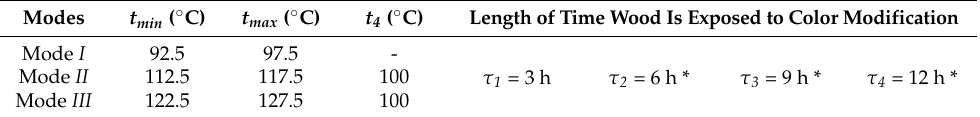
Table 1. Modes of color modification of alder wood with saturated steam-air mixture and saturated water